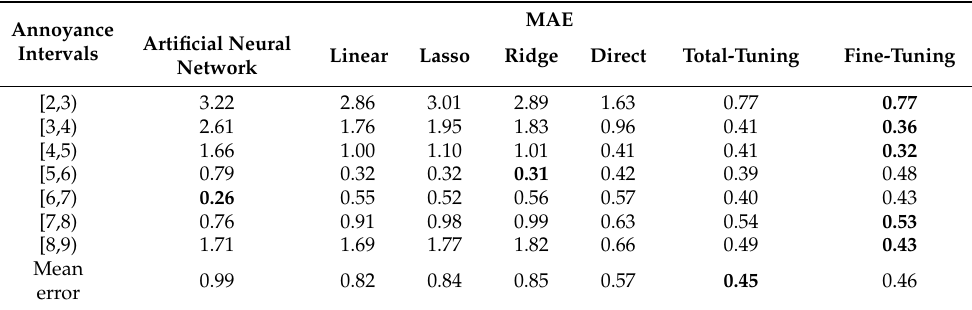
Table 5. Comparison of algorithms on different annoyance intervals from different annoyance intervals. Bold indicates the best score in each interval. The range of MAE is [0,10]. Annoyance Intervals